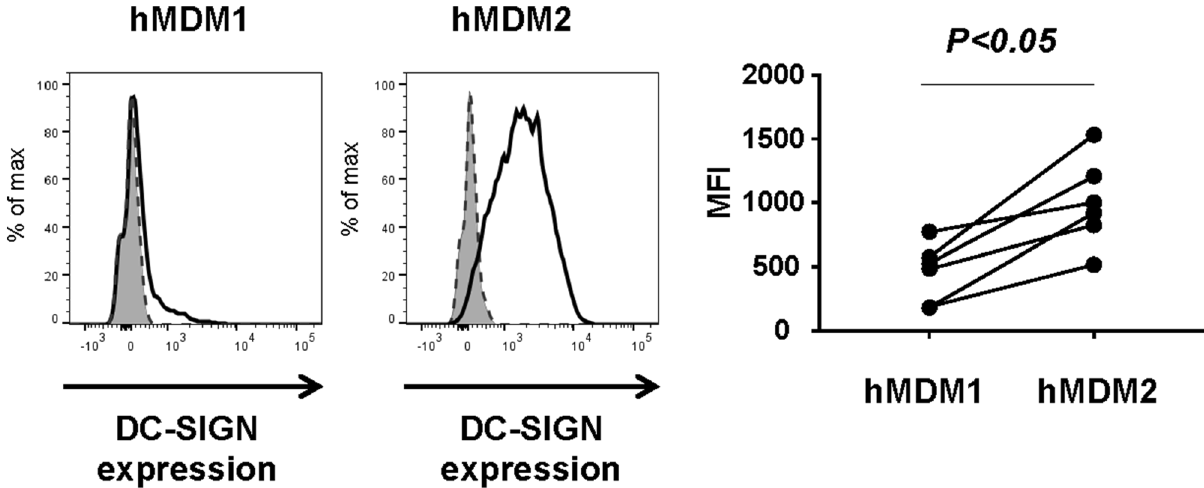
Figure 4. hMDM2, but not hMDM1 expressed DC-SIGN at high levels. hMDM1and hMDM2 were stained with PE-conjugated anti-DC-SIGN mAb. Cell surface expression of DC-SIGN was then measured by FACS. Grey area: cells without the mAb staining, dashed line: cells stained with an isotype control antibody, black line: cells stained with the mAb. Histogram represents three independent experiments using six donors in total. MFI: Mean fluorescence intensity in cells stained with the mAb. Each set of symbols connected by a line represents data from cells of an individual